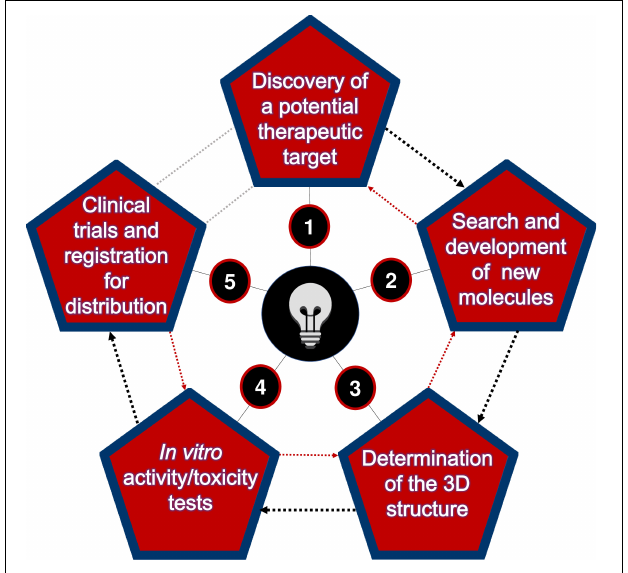
FIGURE 1 | Main milestones to be overcome in the search for new therapeutic